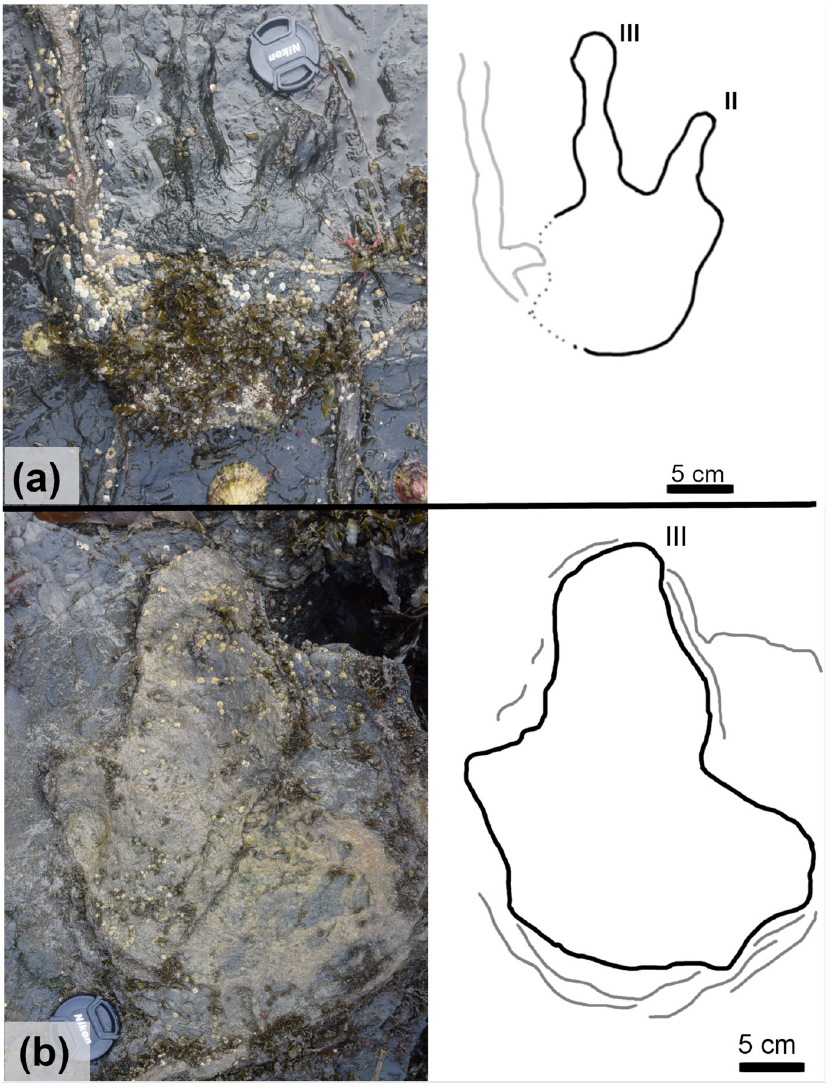
Fig 15. Exemplar tracks from BP1_Twy_02 and BP1_Twy_03. (a) A field photograph and outline drawing of BP1_16 illustrating the presence of remnant phalangeal pads on the positive relief casts present in BP1_Twy_02. (b) A field photograph and outline drawing of the most clearly defined tracks in BP1_Twy_03 (BP1_26). The track is preserved as a broken limestone cast (modifying the true track) set in an area of strong sediment deformation. This deformation is illustrated on the line drawing as thin gray lines concentrated around the track’s